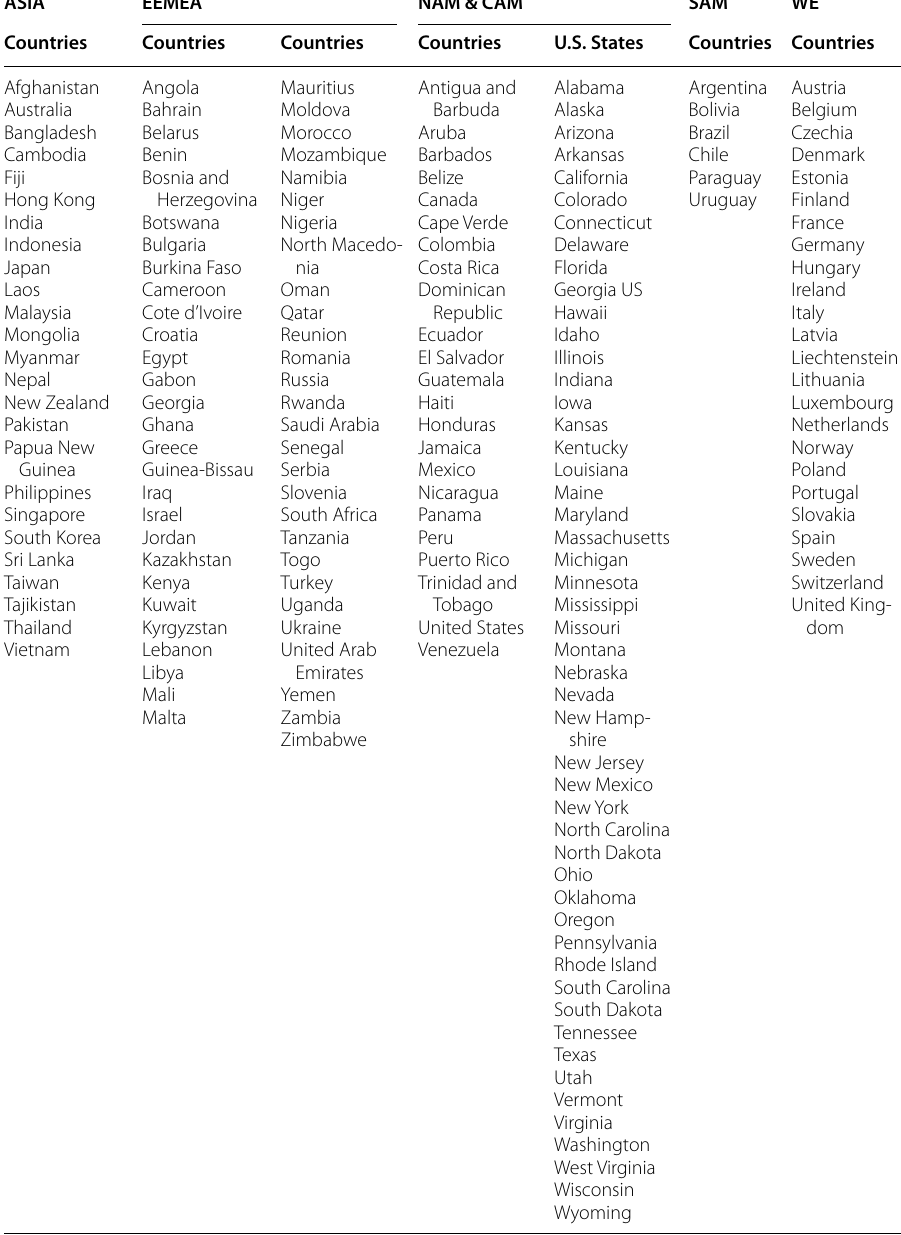
Table 5 Countries and States that have been included in the studies ASIA